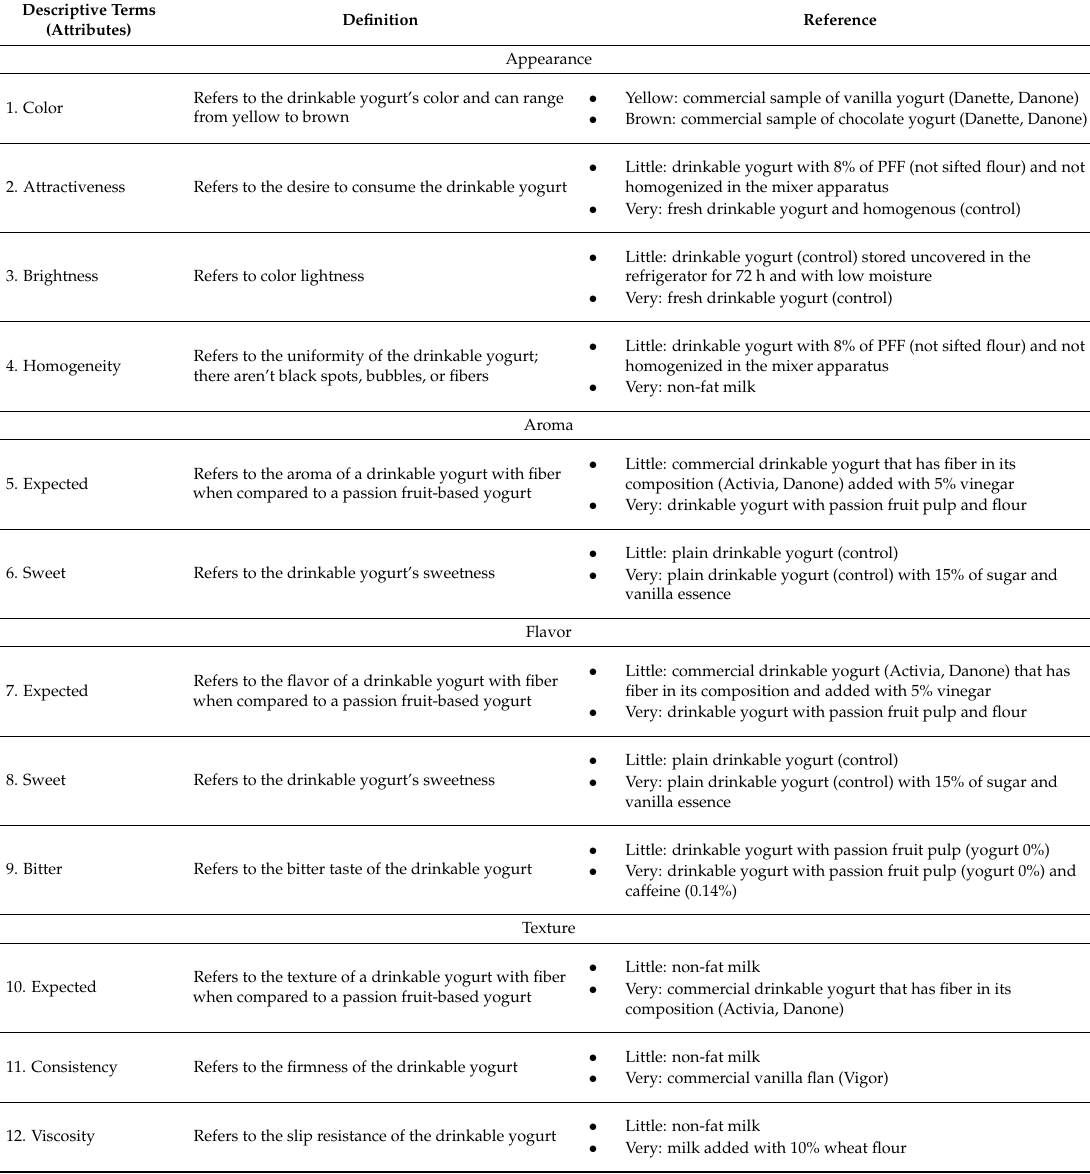
Table 4. Definitions of terms and reference materials used in the sensory descriptive